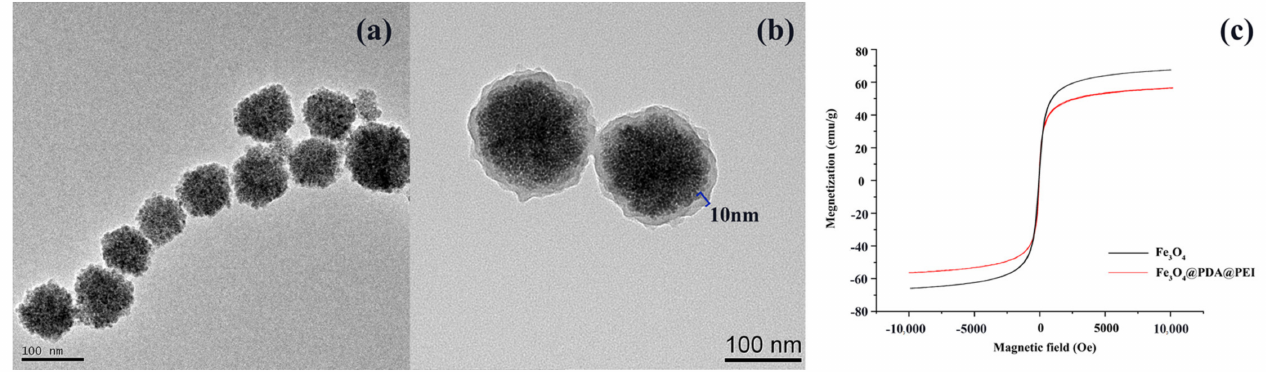
Figure 3. TEM images of ( a ) Fe 3 O 4 and ( b ) Fe 3 O 4 @PDA@PEI; ( c ) VSM images of Fe 3 O 4 and Fe 3 O 4 @PDA@PEI in the temperature of 300